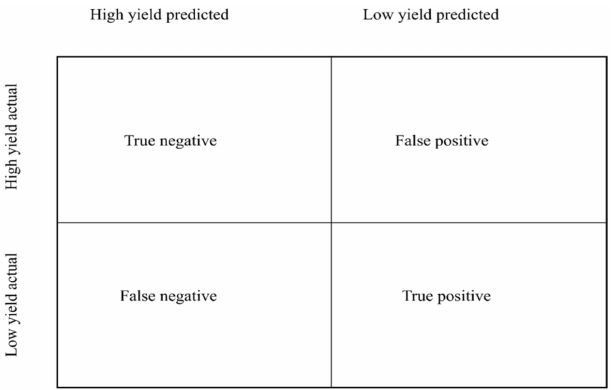
Figure 1. Specimen classification in the confusion matrix into true negative (TN), true positive (TP), false positive (FP), and false negative